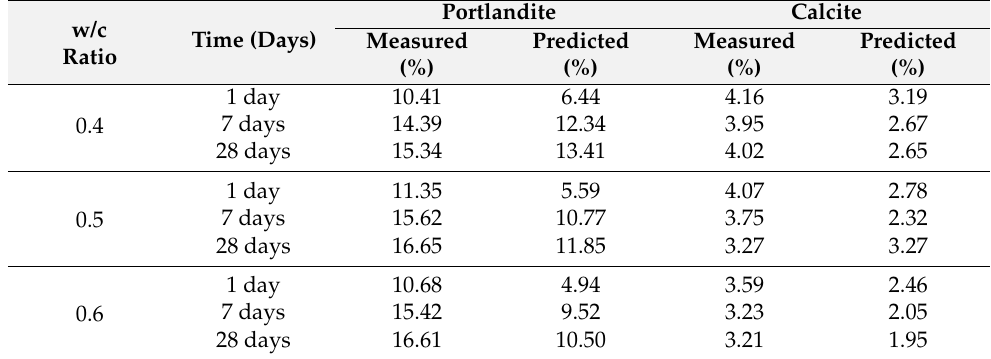
Figure 7. Comparison between measured and predicted portlandite and calcite contents over time.